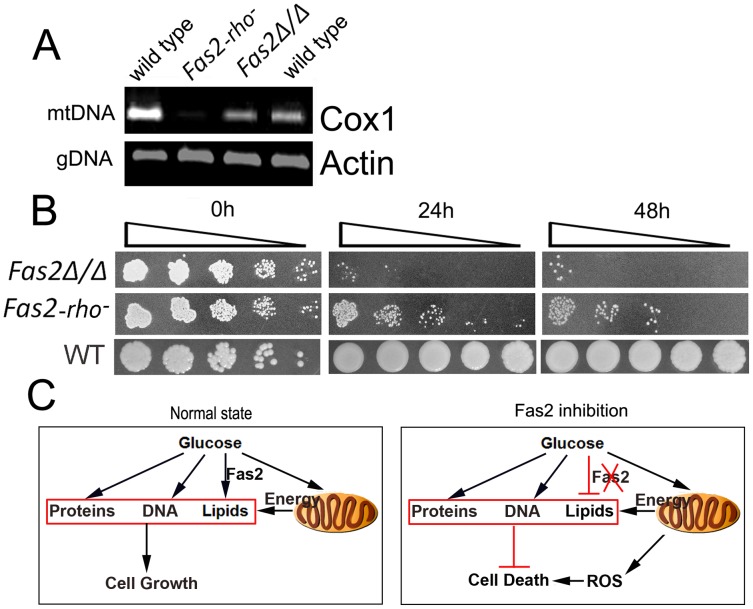
Cell death is dependent on mtDNA.A, mitochondrial DNA and genomic DNA were evaluated by PCR from total DNA isolated from the indicated strains. Mitochondrial DNA content was assessed using the subunit I of cytochrome c oxidase gene (Cox1). Genomic DNA content was determined using the actin gene (Actin). B, Deletion of mtDNA protected Fas2Δ/Δ yeast cells from death induced by culture in serum. WT, Fas2Δ/Δ and Fas2Δ/Δ with partially deleted mtDNA (Fas2-rho−) were incubated with 50% serum for 24 and 48 h. Aliquots were serially diluted and WT yeast were spotted onto YPD whereas the Fas2Δ/Δ mutants were inoculated onto YPDT40. Experiments were performed twice with similar results. C, A proposed model of yeast cell sensitivity to glucose in the media in the setting of fatty acid inhibition.